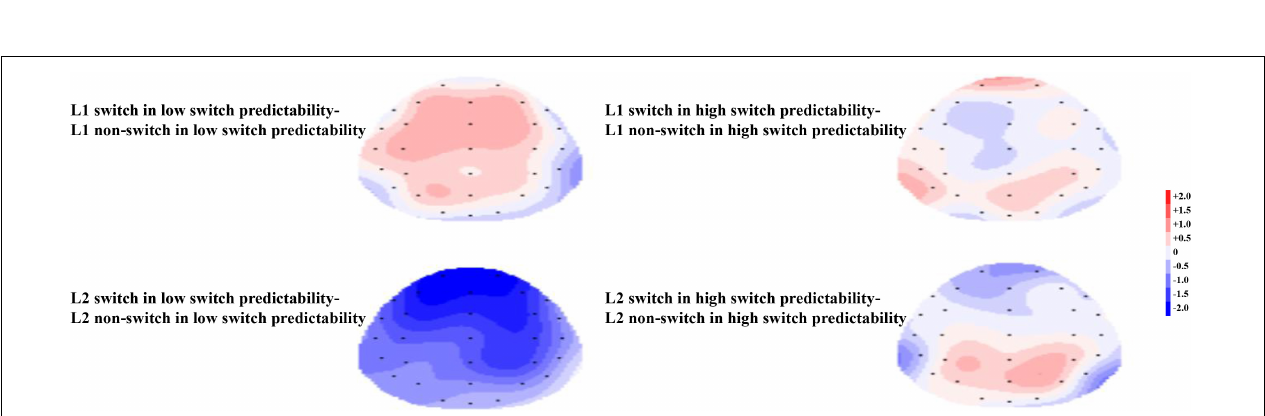
FIGURE 5 | (Left) For the low switch predictability condition, the grand average of the early phase elicited by language cues for naming digits in L1 and L2 at the Fz electrode. (Right) For the high switch predictability condition, the grand average of the early phase elicited by language cues for naming digits in L1 and L2 at the Fz electrode.